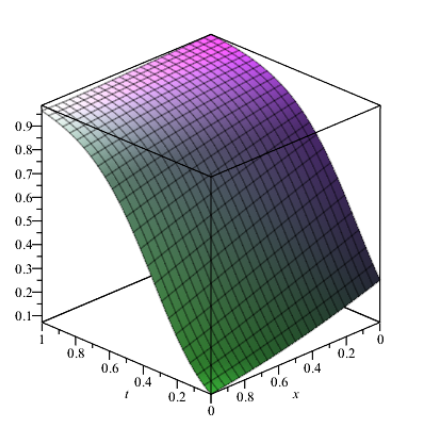
Figure 1. Graph of Chebyshev wavelet solutions with k = 1, M = 8.